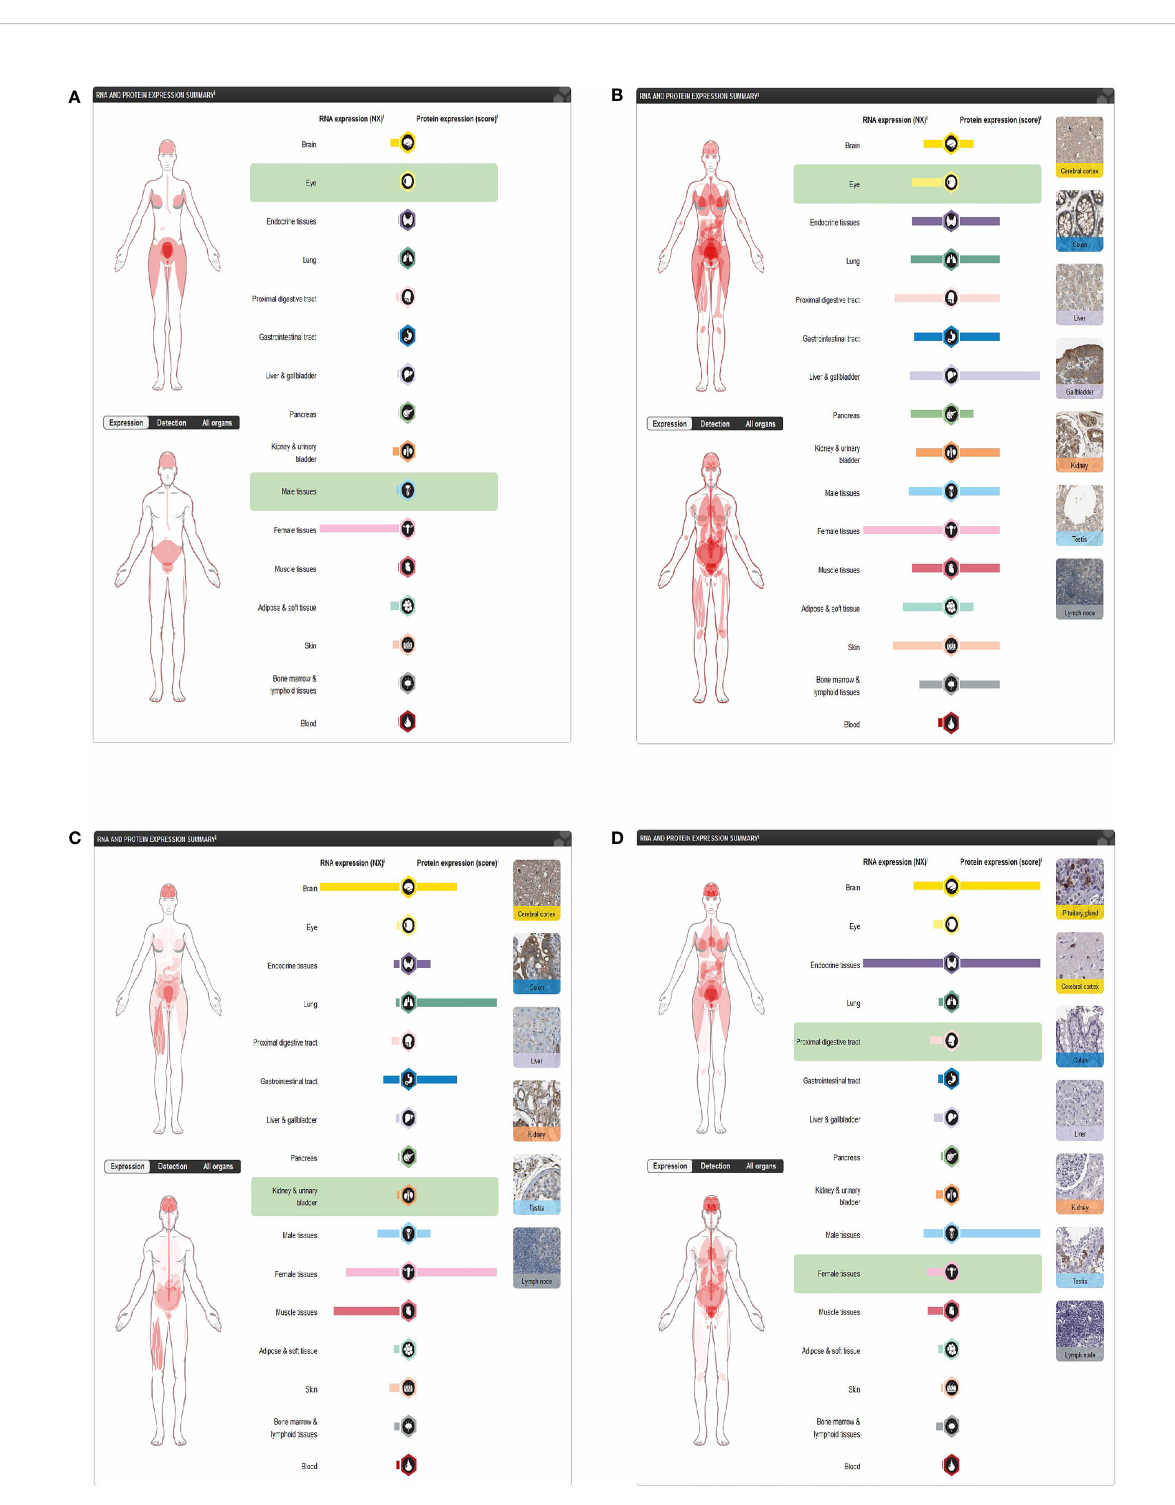
FIGURE 8 Expression of four differentially expressed immune-related genes. (A) DKK1 in the Human Protein Atlas. (B) JAG1 in the Human Protein Atlas. (C) LGR5 in the Human Protein Atlas. (D) PTN in the Human Protein